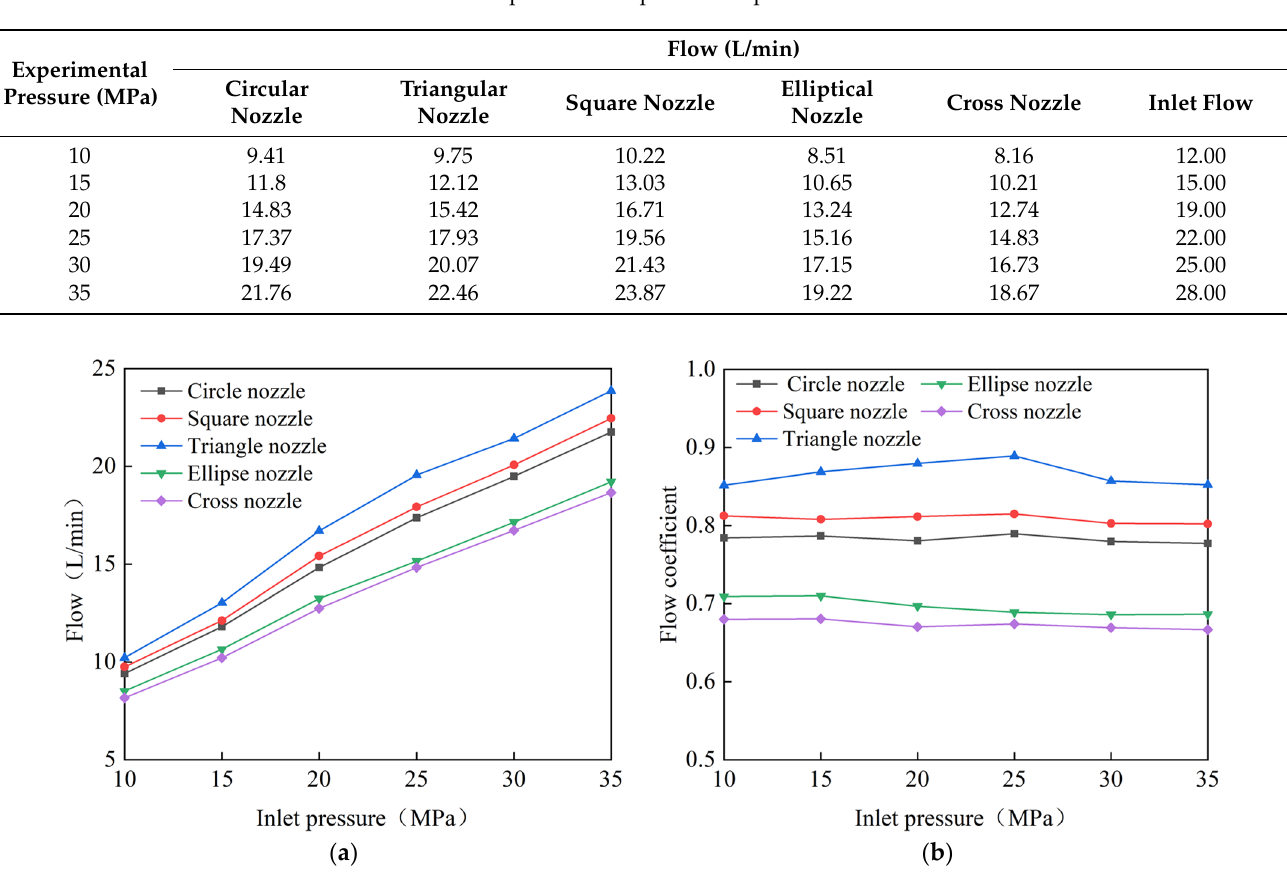
Table 3. Relationship between experimental pressure and flow of each nozzle.